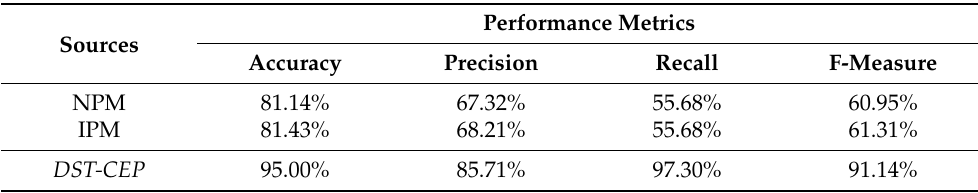
Table 7. Results of performance metrics from the probabilistic